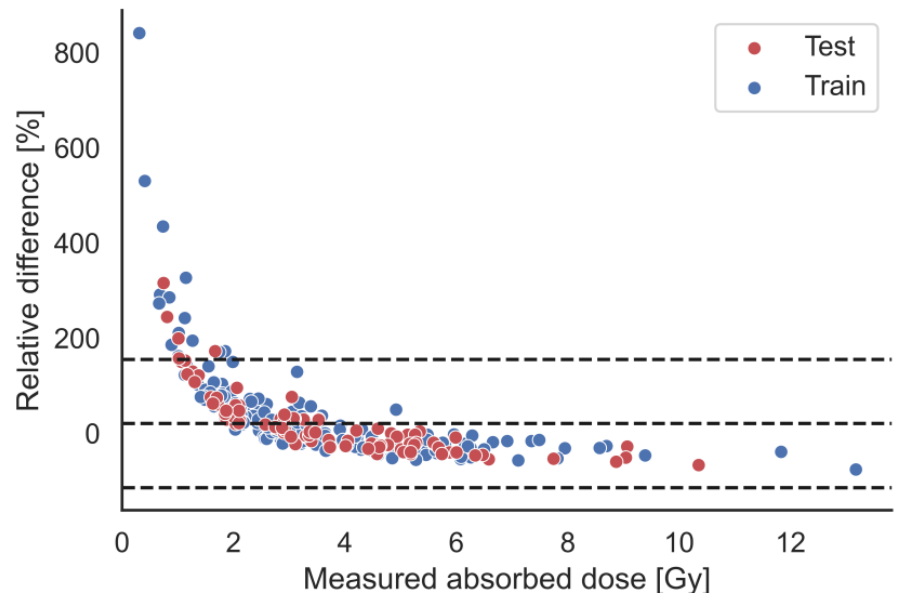
Figure 4. Relative error between predicted and calculated absorbed dose. The central dashed line is the average bias and the lower and upper 95% confidence intervals for the test are marked. Colours indicate whether the data point is from the training- or test-set. The predicted absorbed doses are calculated from parameters found in the training data set.